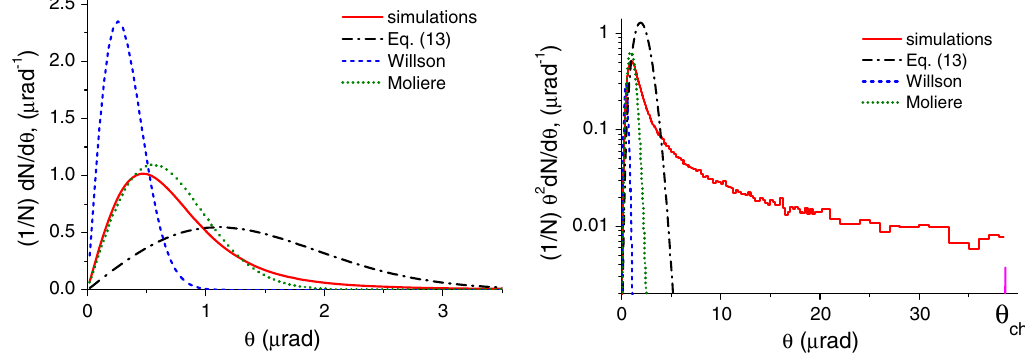
FIG. 7. Particle number (left) and angle square (right) distributions of 150 GeV electrons, scattered within a typical trajectory simulation step (17): simulated directly (solid, red line) and evaluated using Gaussian polar angle distribution with mean square angles determined by the usual (13) (dash-dotted, black line), Williams ’ s (dashed, blue line), and Moliere ’ s (dotted, green lines)